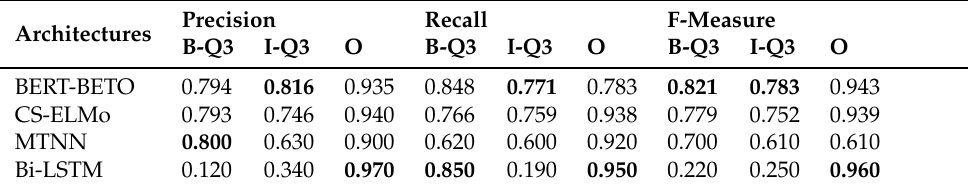
Table 3. Results for question Q3: How are you going to do it? Architectures